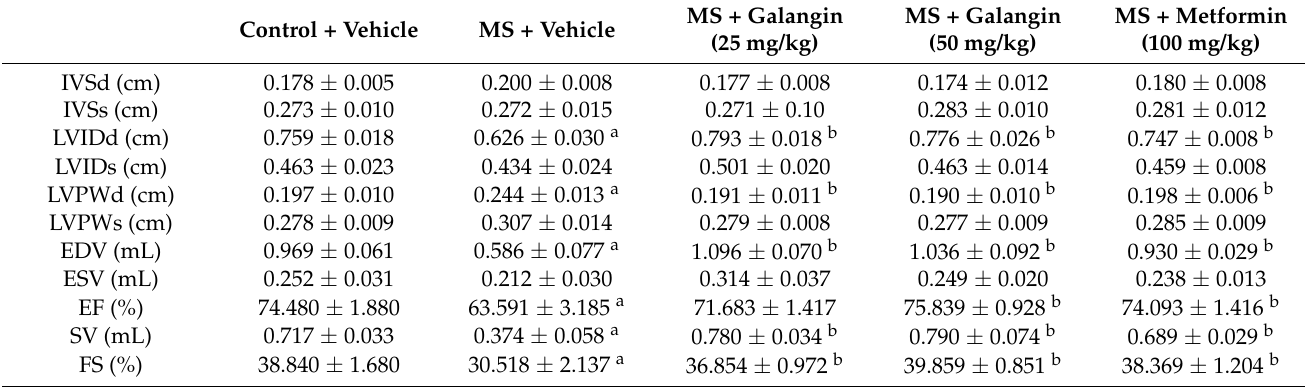
Table 4. Effects of galangin and metformin treatments on transthoracic echocardiographic parameters in rats with high-fat diet-induced metabolic